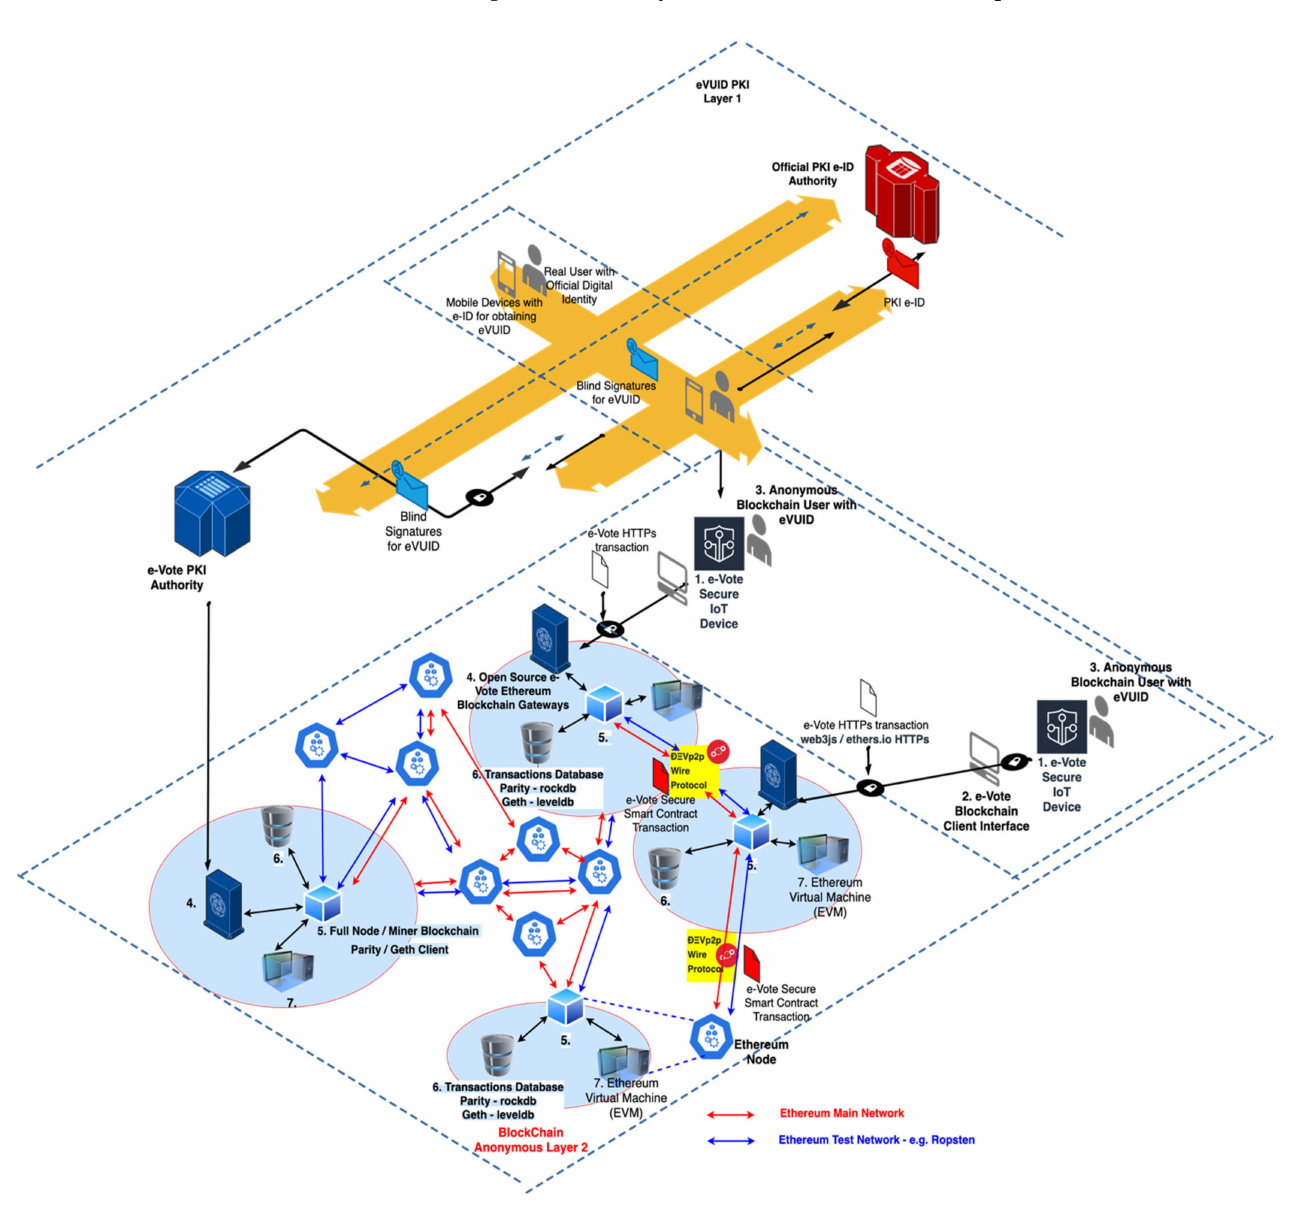
Figure 8. Detailed Layer 2 of the e-VoteD-App Solution based on Ethereum Blockchain and Smart Contracts running in